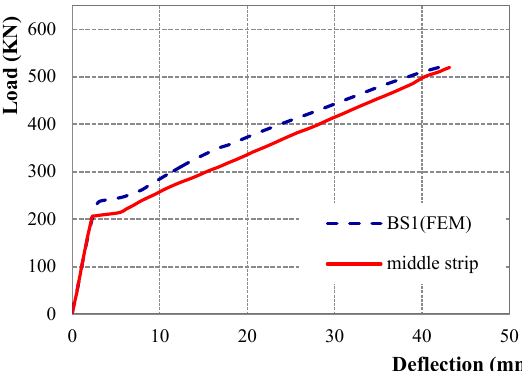
Figure 36. Comparison between field laminate results with BS1.